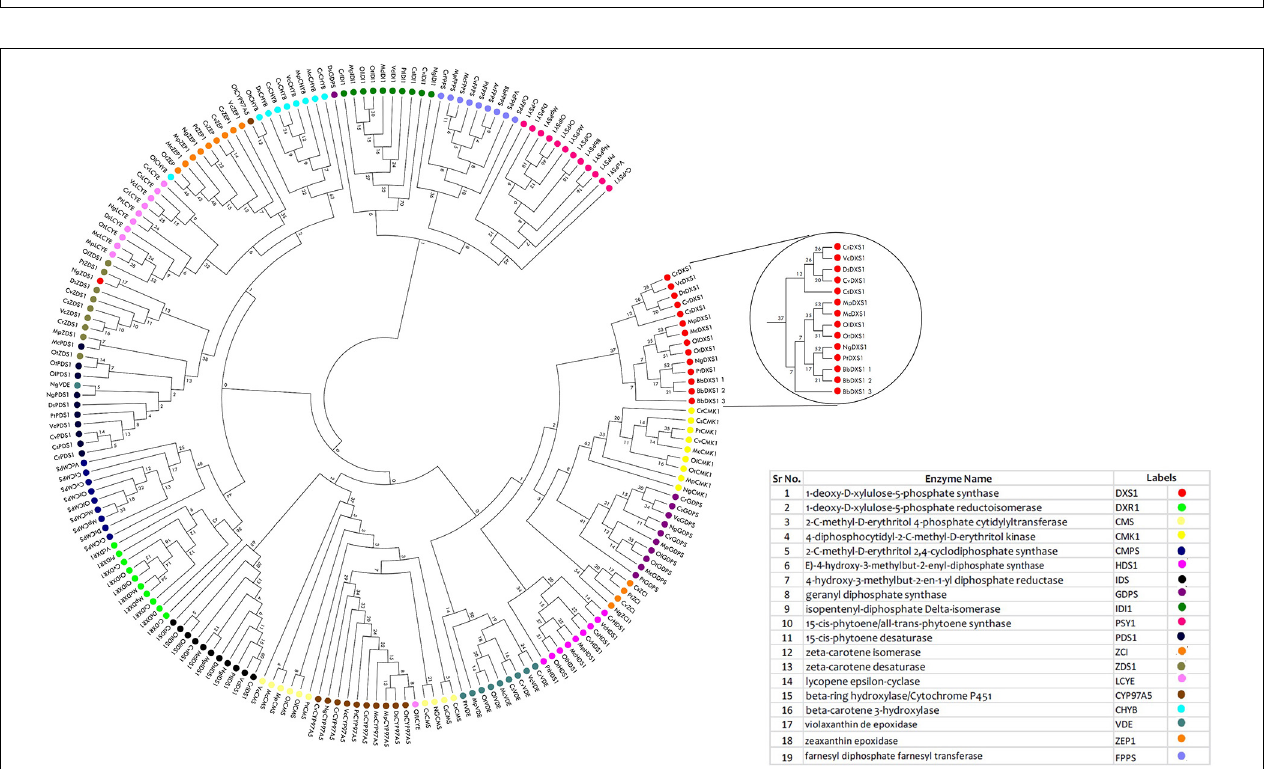
FIGURE 5 | Phylogenomic tree constructed for methyl erythritol phosphate (MEP) pathway proteins employing neighbor-joining (N-J) method with evaluation of 1,000 rounds of bootstrapping test using MEGA 10.0. Each colored symbol denotes a specific protein, and the highlighted circle represents the rate-limiting enzyme deoxy xylulose phosphate synthase (DXS1) found to be conserved among microalgal species.